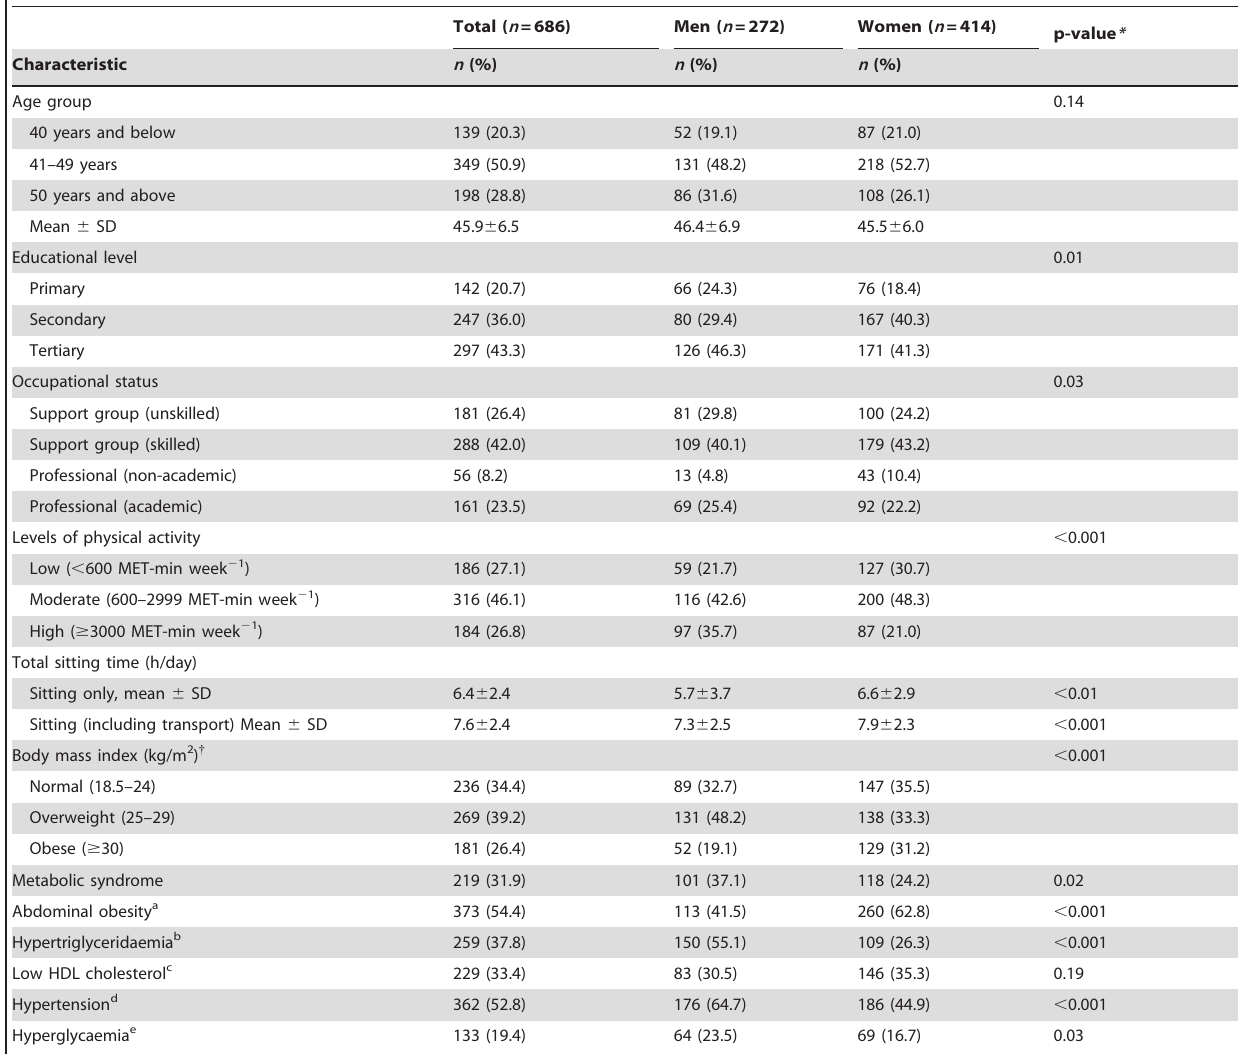
Table 1. Characteristics of the